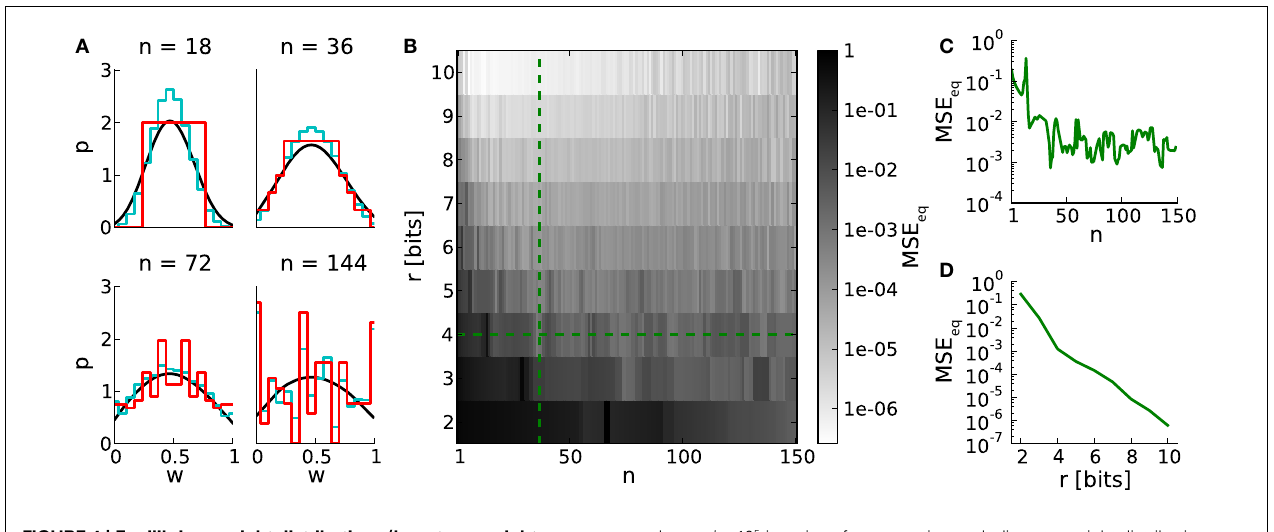
FIGURE 4 | Equilibrium weight distributions (long-term weight evolutions) for configurations of STDP on discrete weights. (A) Equilibrium weight distributions for weight resolutions of r = 4 bits (red) and r = 16 bits (cyan). Both distributions are displayed in 4-bit sampling, for better comparison. Black curves depict the analytical approach.We have